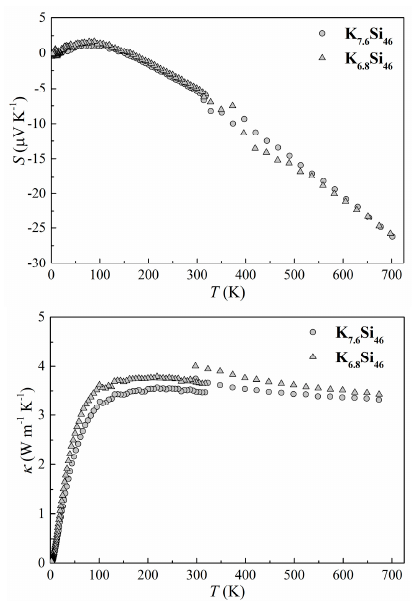
Figure 6. Transport properties of polycrystalline K 7.6 Si 46 and K 6.8 Si 46 . The low temperature, 2 to 300 K, and high temperature, 300 to 700 K, are described in the text. ( Top ) electrical resistivity ρ ; ( Middle ) Seebeck coefficient S ; ( Bottom ) thermal conductivity κ .